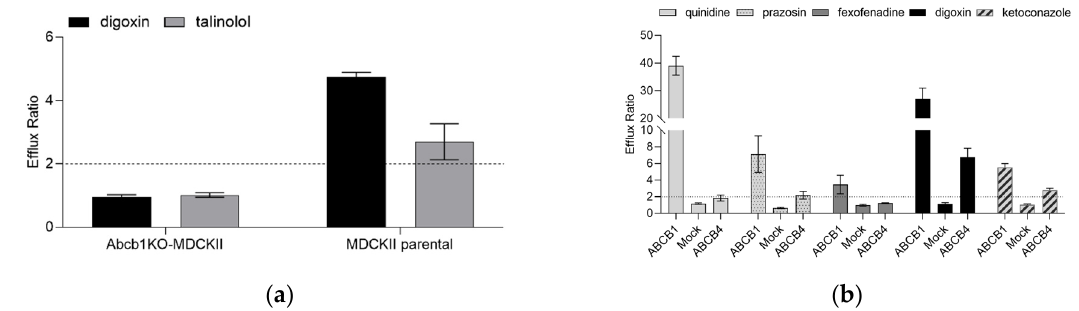
Figure 1. Efflux ratios for prototypic ABCB1 substrates. ( a ) Efflux ratios for digoxin and talinolol (1 µM, traced with 0.17 µCi/mL 3 H-labelled probe) in the MDCKII parental and in the Abcb1KO cells. The dashed line indicates an efflux ratio of 2. Data are presented as mean ± standard deviation for 3 experiments each performed in triplicate. ( b ) Functional characterization of ABCB1, Mock and ABCB4 cells using prototypical ABCB1 substrates (1 µM, traced with 0.17 µCi/mL 3 H-labelled probe). The dashed line indicates an efflux ratio of 2. Data are presented as mean ± standard deviation for 3 experiments each performed in triplicate.